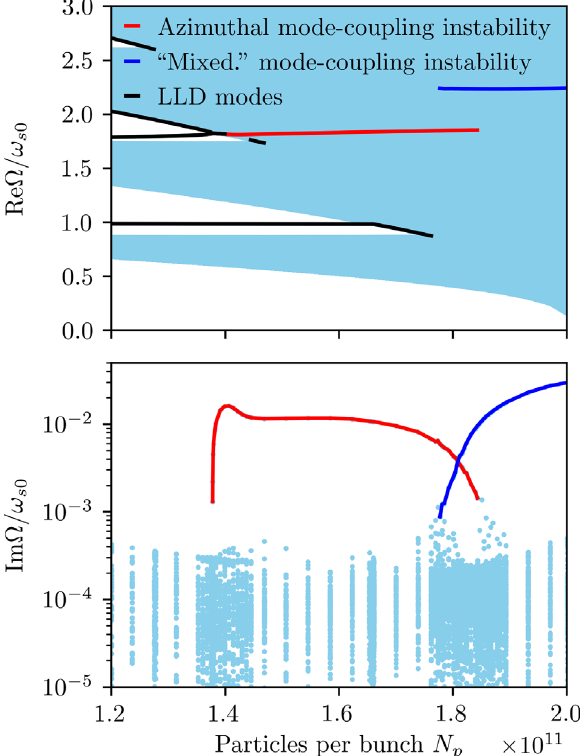
FIG. 8. Real (sorted and joined by light blue lines, top) and imaginary (blue dots, bottom) as functions of bunch intensity for E ¼ 0 . 12 (bunch parameters correspond to those indicated by max the black line in Fig. 3). Black lines show the frequencies of the mode for which Landau damping is lost. The red and blue lines indicate the unstable